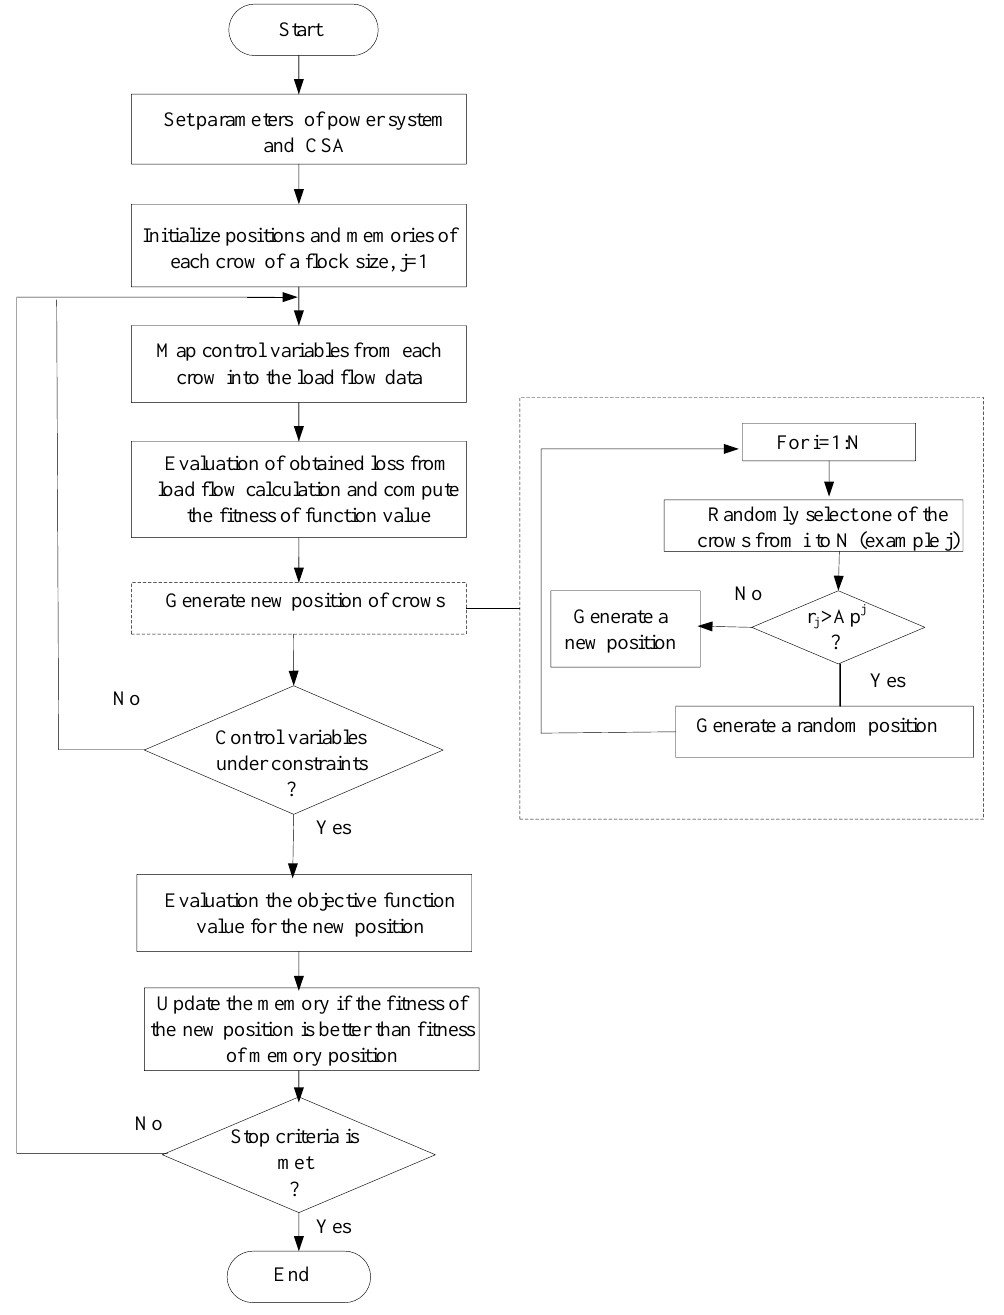
Figure 2. Flowchart of the proposed CSA algorithm for solving